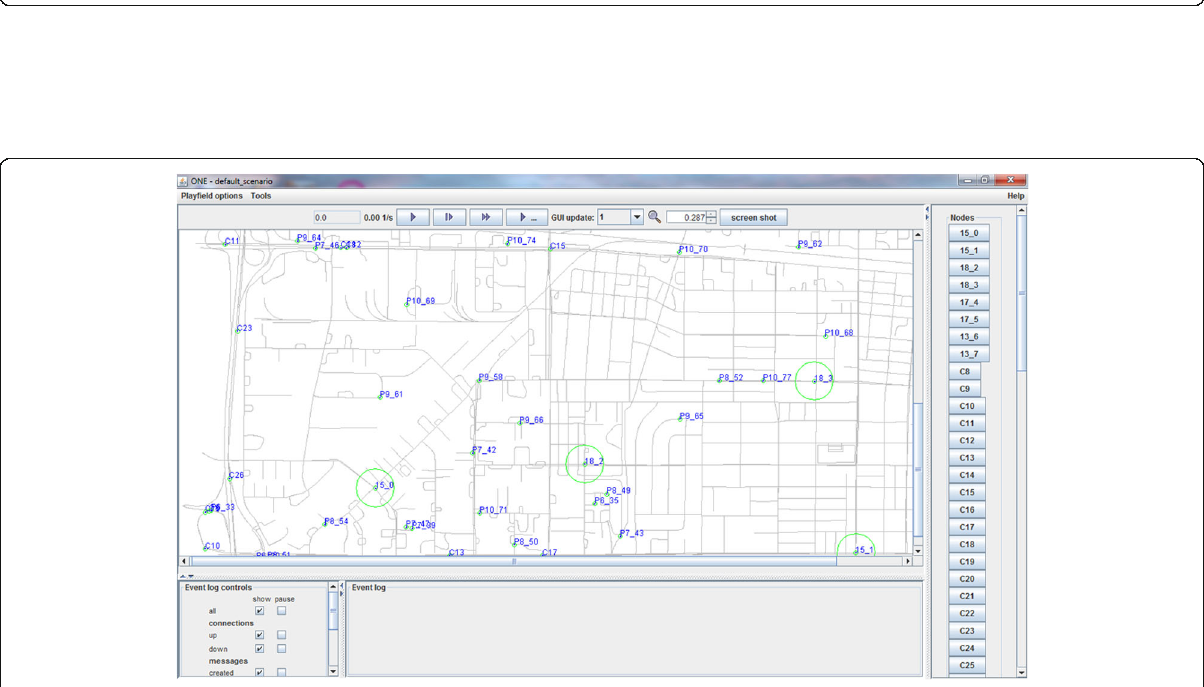
Fig. 6 A portion of map opened in OpenJUMP. The dots on the map indicate the specific points of interest (POI). The different colors are used just to represent different types of POIs such as shopping malls, restaurants, or